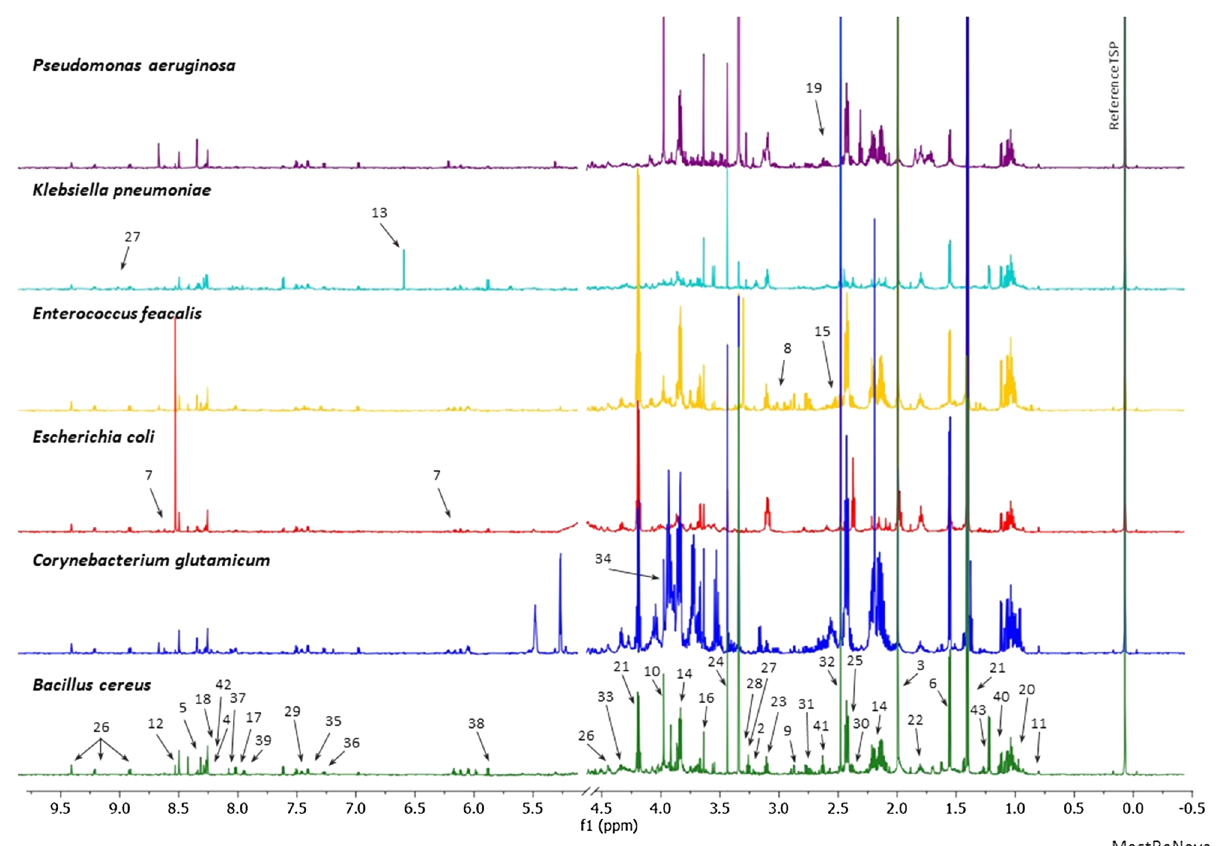
Figure 2. The representative 1D 1 H NMR cpmgpr1d spectra obtained from different bacteria strains.